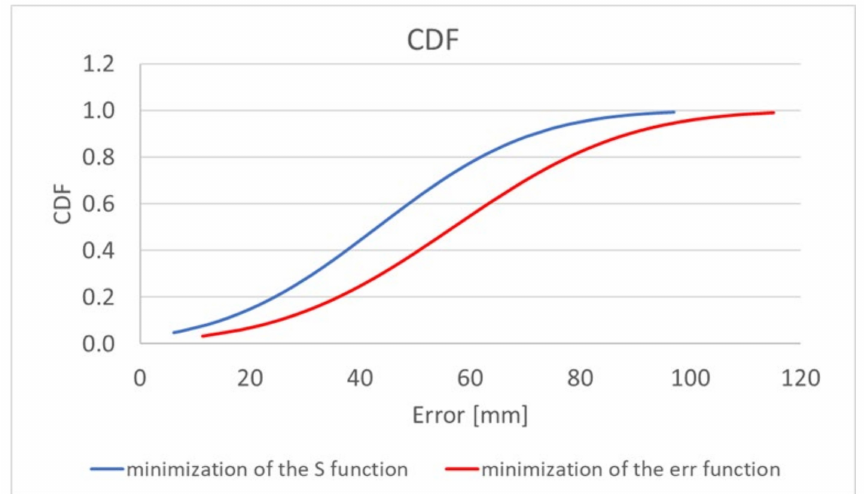
Figure 6. Cumulative distribution function (CDF) of localization error